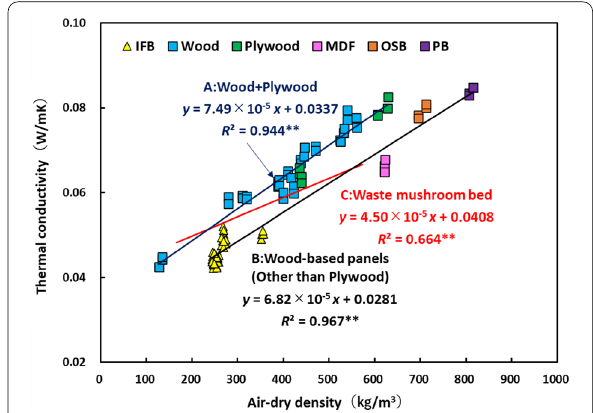
Fig. 8 Relationship between air-dry density and thermal conductivity for the waste mushroom bed and comparison materials